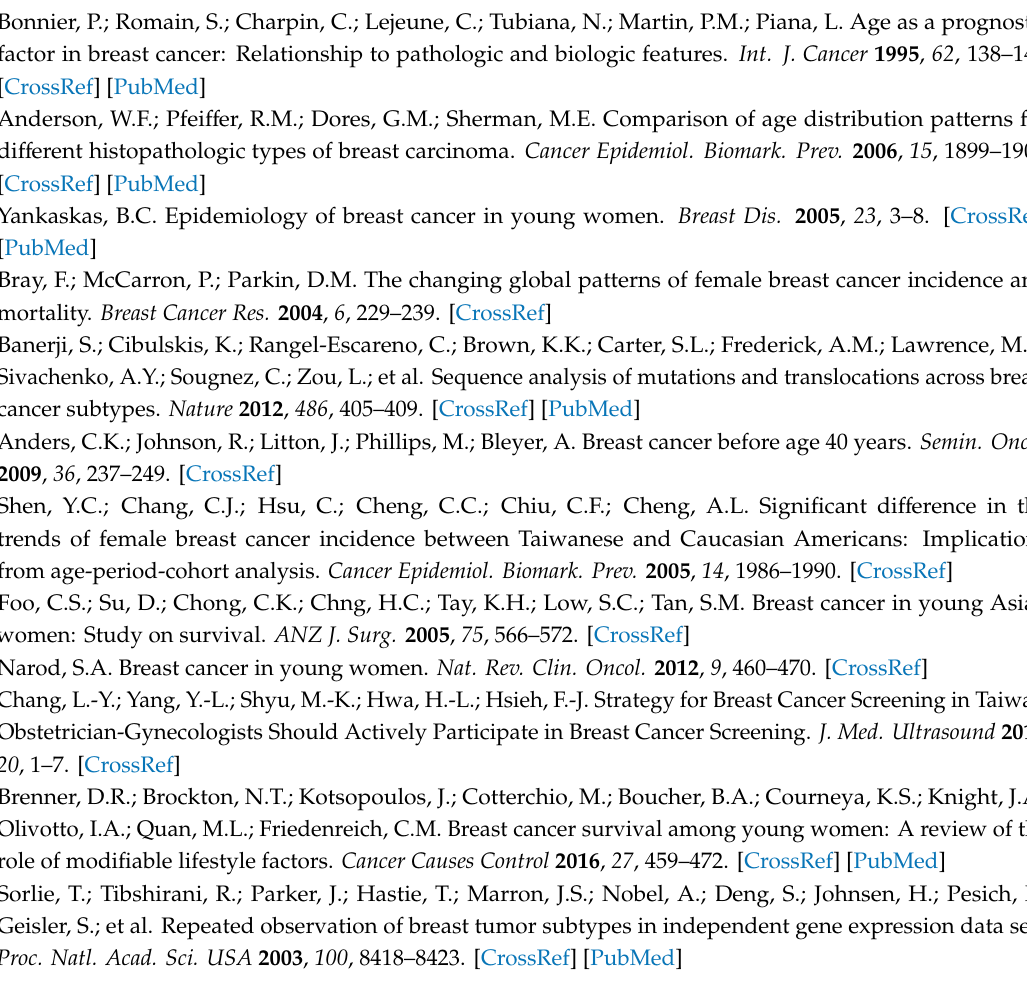
cancer, Supplementary Table S1: Library statistics, Supplementary Table S2: Characterization of somatic mutations, Supplementary Table S3: Clinical information and somatic mutations of all Taiwanese EOBC patients (As of May, 2017), Supplementary Table S4: Subtype-based top genes with somatic mutations, Supplementary Table S5: Description of non-Taiwanese breast cancer cohorts used for comparison, Supplementary Table S6: Di ff erentially mutated genes in pooled EOBC and pooled non-EOBC of external cohorts, Supplementary Table S7: Copy number variations in di ff erent cytobands by subtype, Supplementary Table S8: Overlap in CNV regions between sisters 7768 and